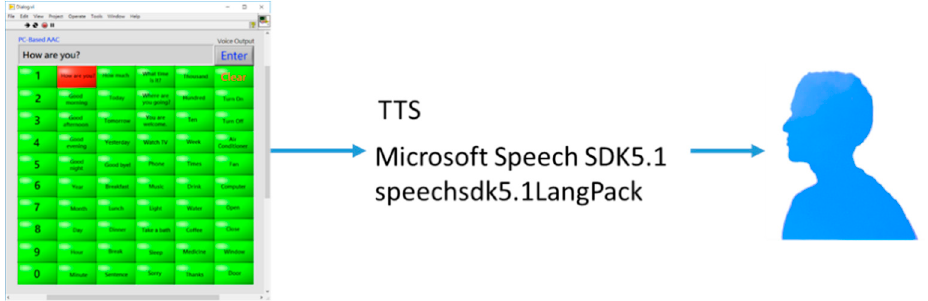
Figure 6. The user interface of personal computer-based alternative augmentative communication (PC-based AAC) with voice output included in WHAS.